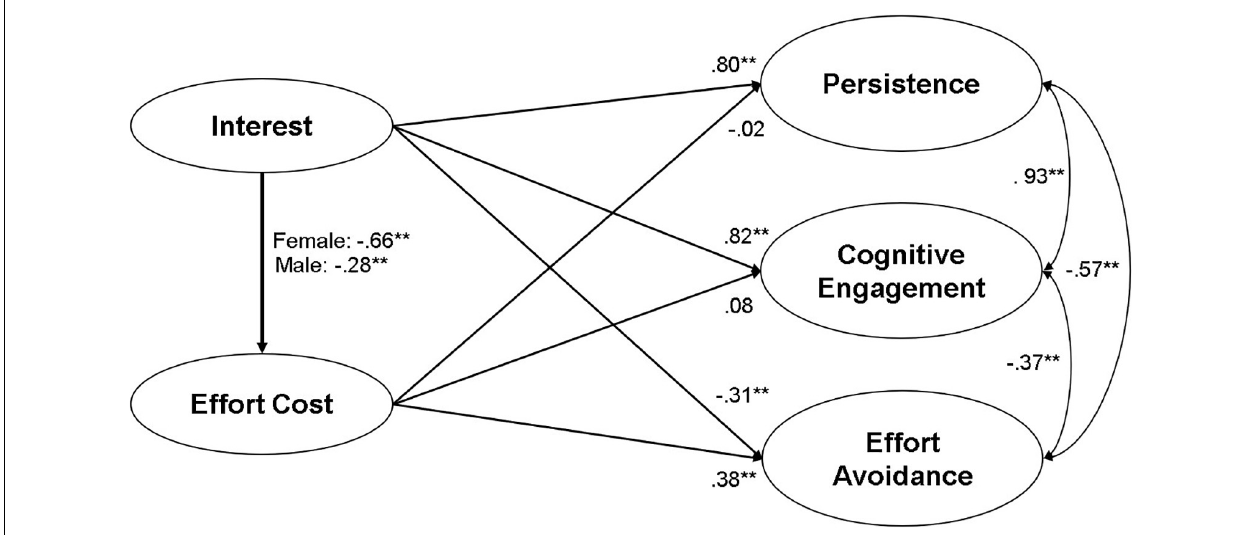
FIGURE 3 | Results from SEM and multi-group analysis. The standardized coefficients for male and female students are separately presented only for the interest-effort cost path that is significantly different between the two. For clarity, indicators, measurement errors, and disturbance terms are not presented. ∗∗ p <